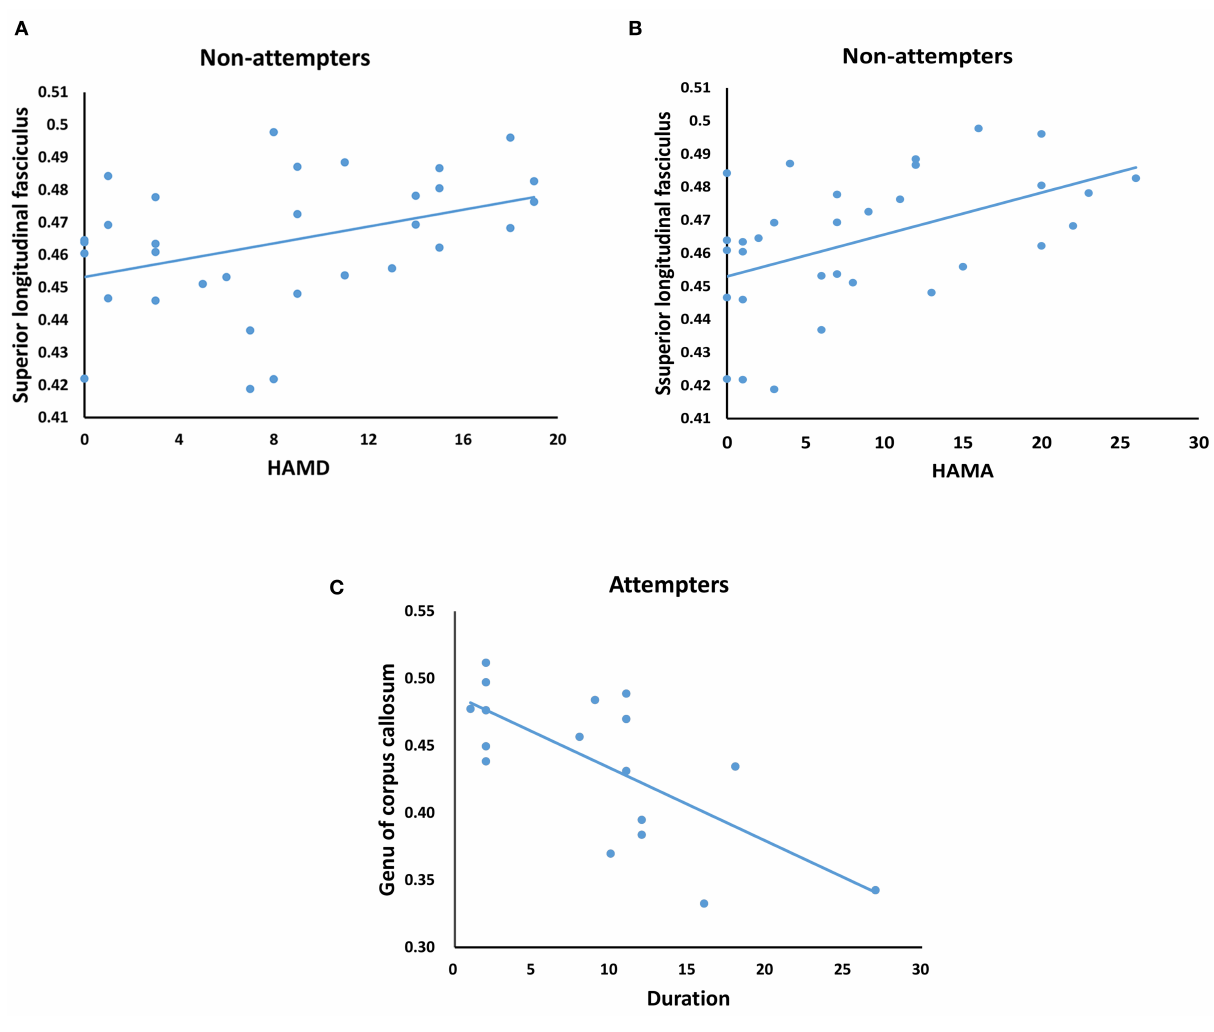
FIGURE 4 | Correlations between clinical measurements and FAs in attempters and non-attempters. (A,B) The HAMD score (A) and HAMA score (B) of non-attempters were positive correlated with the FA value of superior longitudinal fasciculus. (C) The illness duration of Attempters was negative correlated with the FA value of genu of corpus callosum. Significant at p <